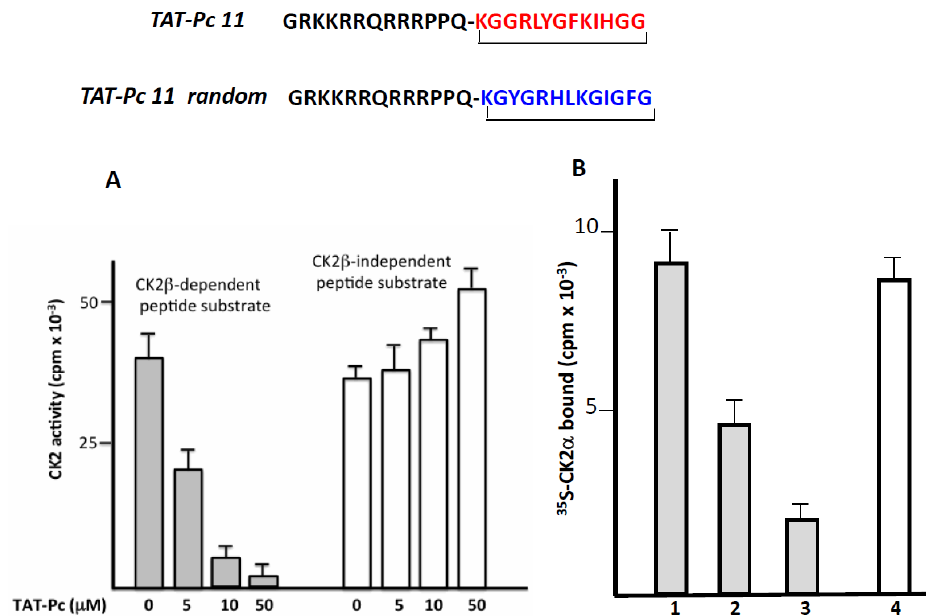
Figure 4. Inhibitory activity of a TAT-Pc analogue in vitro. ( A ) CK2 holoenzyme (100 nM) was incubated in the presence of increasing concentrations of TAT-Pc 13 for 15 min at 4 ◦ C. CK2 activity was then determined with CK2 β -dependent or independent peptide substrates; ( B ) [ 35 S]-labeled CK2 α was incubated with biotinylated MBP-CK2 β immobilized on streptavidin coated plates (preformed complex) in the absence (1) or presence (2) of TAT-Pc 13. Alternatively, [ 35 S]-labeled CK2 α was incubated with TAT-Pc 13 (3) or random TAT-Pc 13 (4) and then with immobilized biotinylated MBP-CK2 β . After washing, the amount of [ 35 S]-labeled CK2 α remaining in the complex was determined by radioactivity counting. Representative data shown from two independent experiments. Results are presented as mean ± s.d. of triplicates.